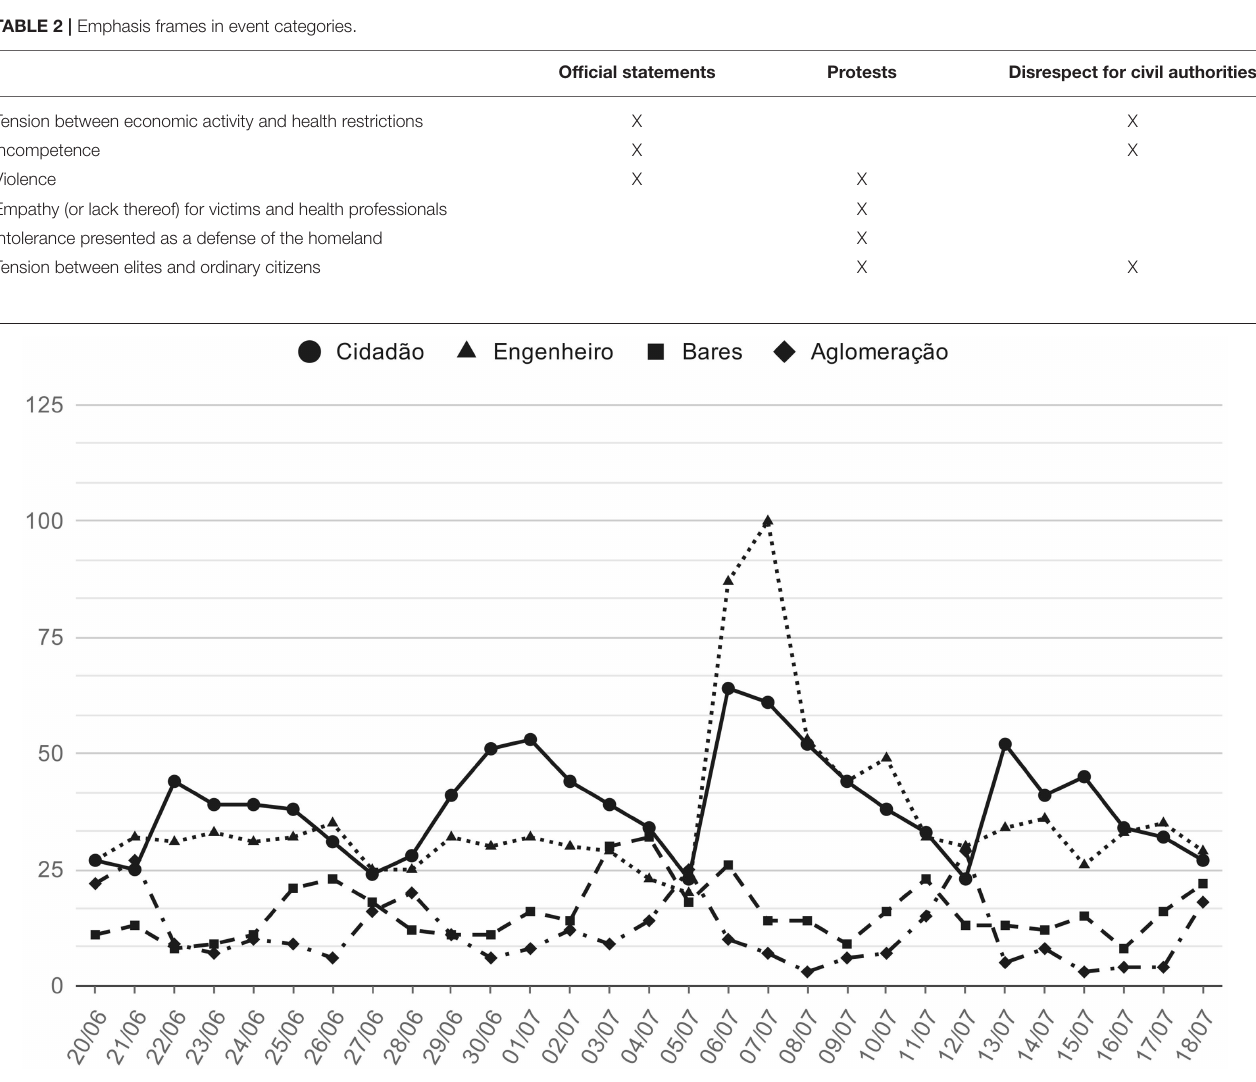
FIGURE 6 | Web Search for “citizen,” “engineers,” “bars” and “overcrowding” between 6/20/20 and 7/18/20. https://trends.google.com/trends/explore?date=2020- 07-01%202020-08-10&geo=BR&q=cidad%C3%A3o,engenheiro,bares,aglomera%C3%A7%C3%A3o.